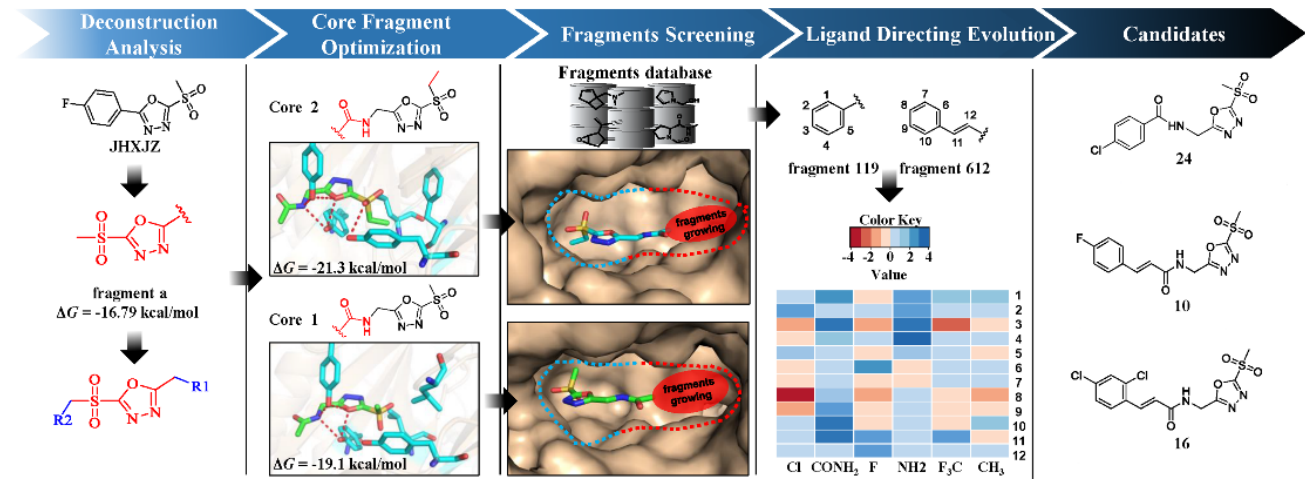
Figure 1. The fragment-based virtual screening: the structural optimization of JHXJZ. DLST was verified as the target of JHXJZ by the click chemistry and